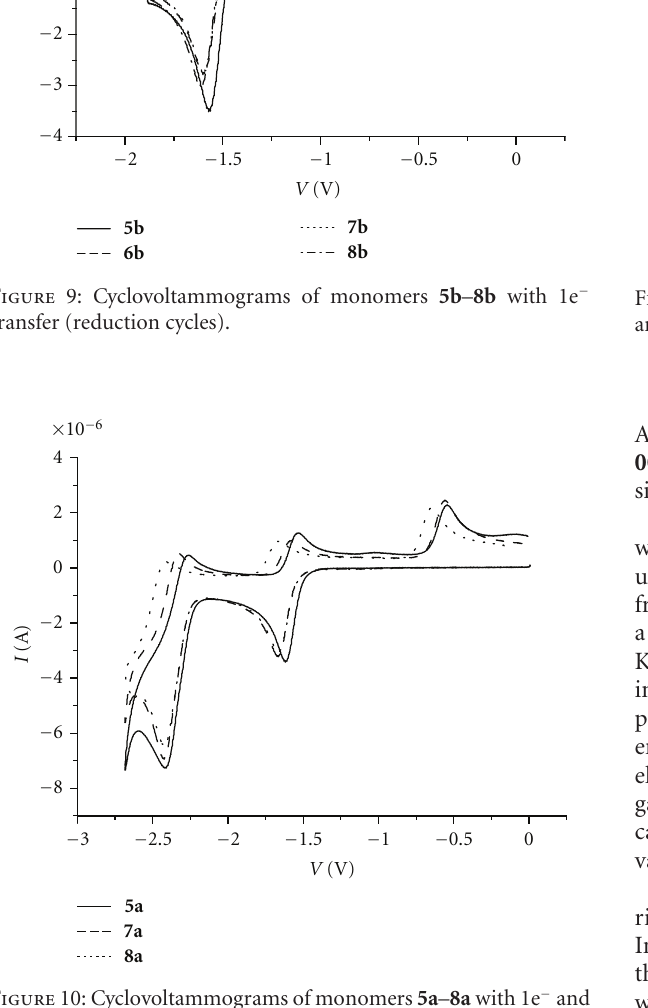
Figure 10: Cyclovoltammograms of monomers 5a – 8a with 1e − and 2e − transfer (reduction cycles).